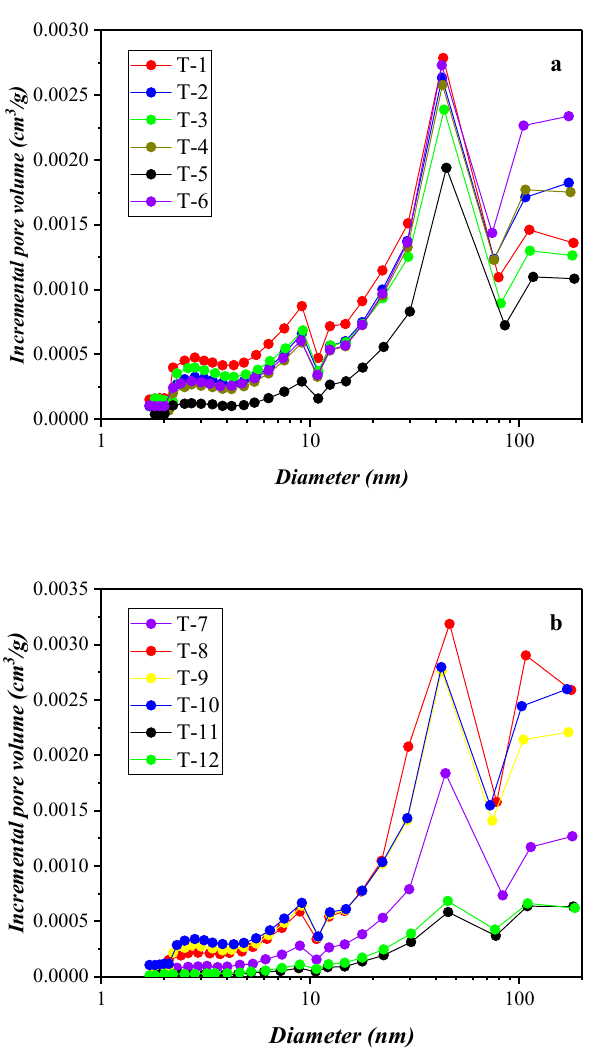
Figure 4. Pore size distribution obtained from the low-temperature nitrogen adsorption experiment for the 12 shale samples: ( a ) The first six shale samples, ( b ) The last six shale samples.